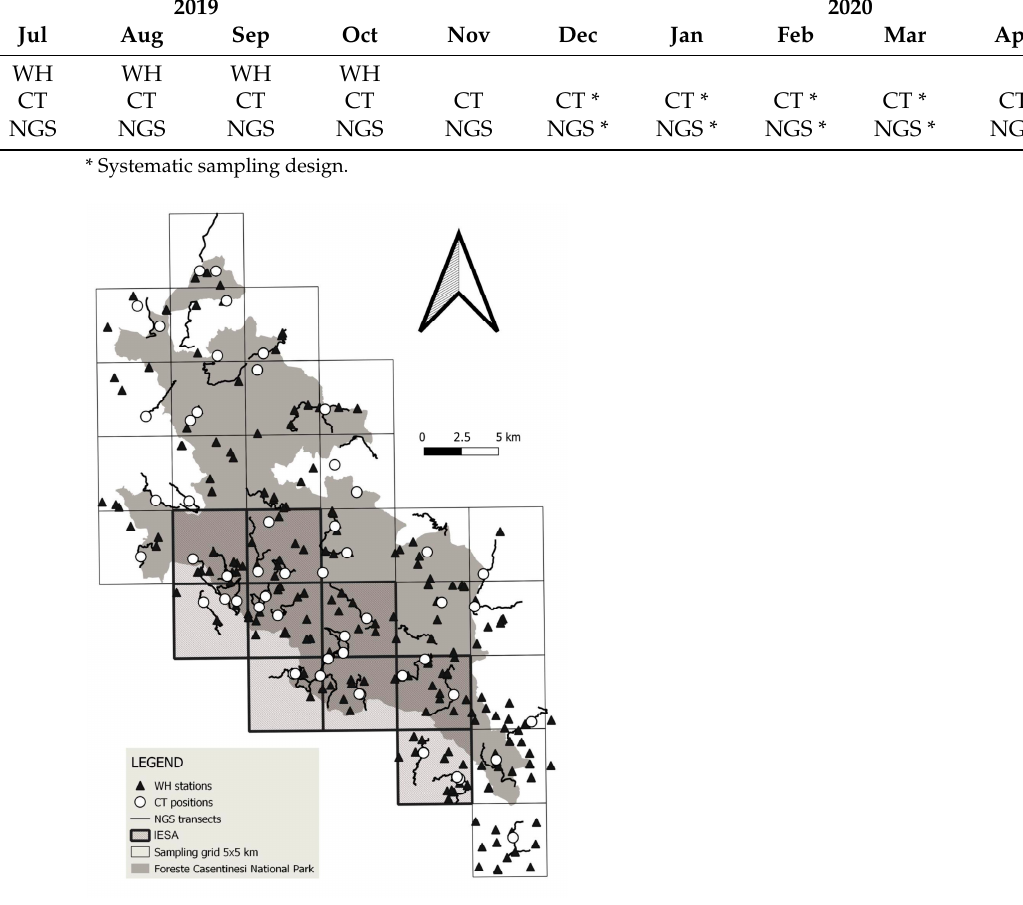
Figure 2. Sampling effort in the study area. The legend shows the types of sampling sites: wolf howling (WH), camera trapping (CT), and non-invasive genetic sampling (NGS).